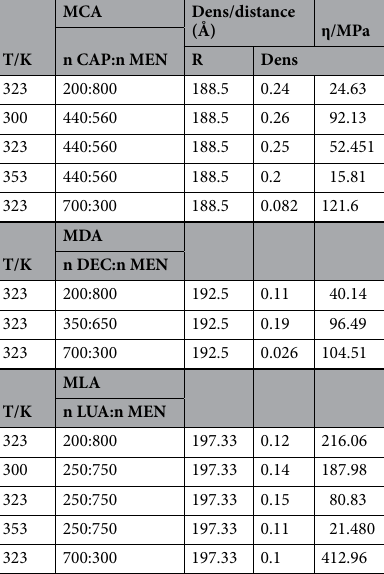
Table 3. The density distribution function (Dens) of the HA atom of MEN around the OA atom of FAs in the mixtures and the shear viscosity (η) of the binary mixtures from simulations.